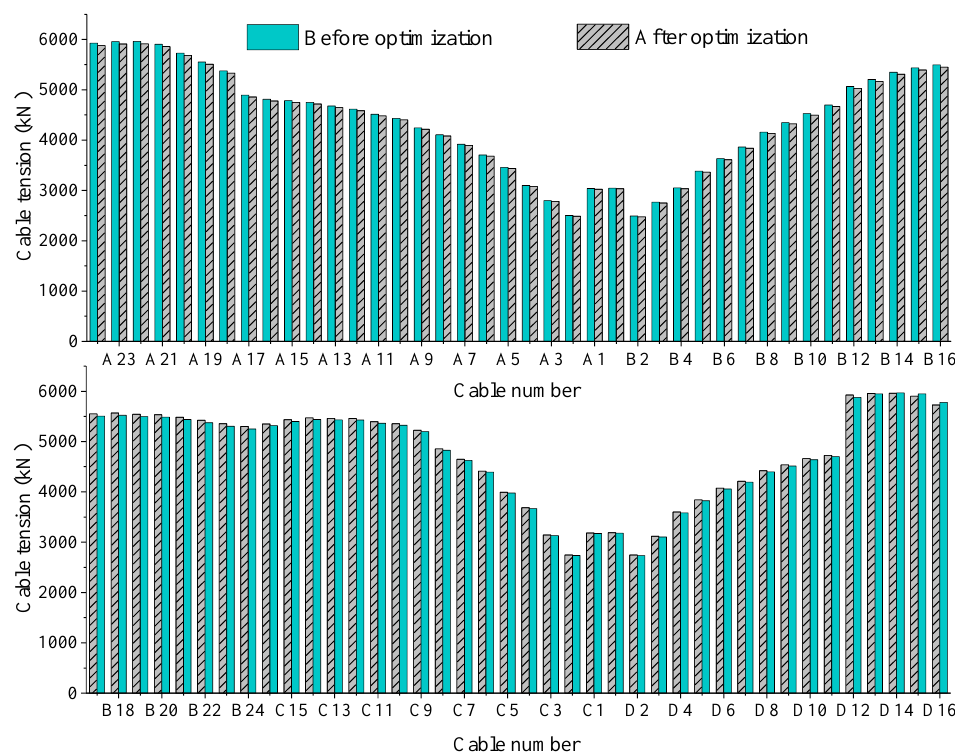
Figure 18. Mechanical performance of the high pylon. ( a ) Bending moment. ( b ) Longitudinal displacement.